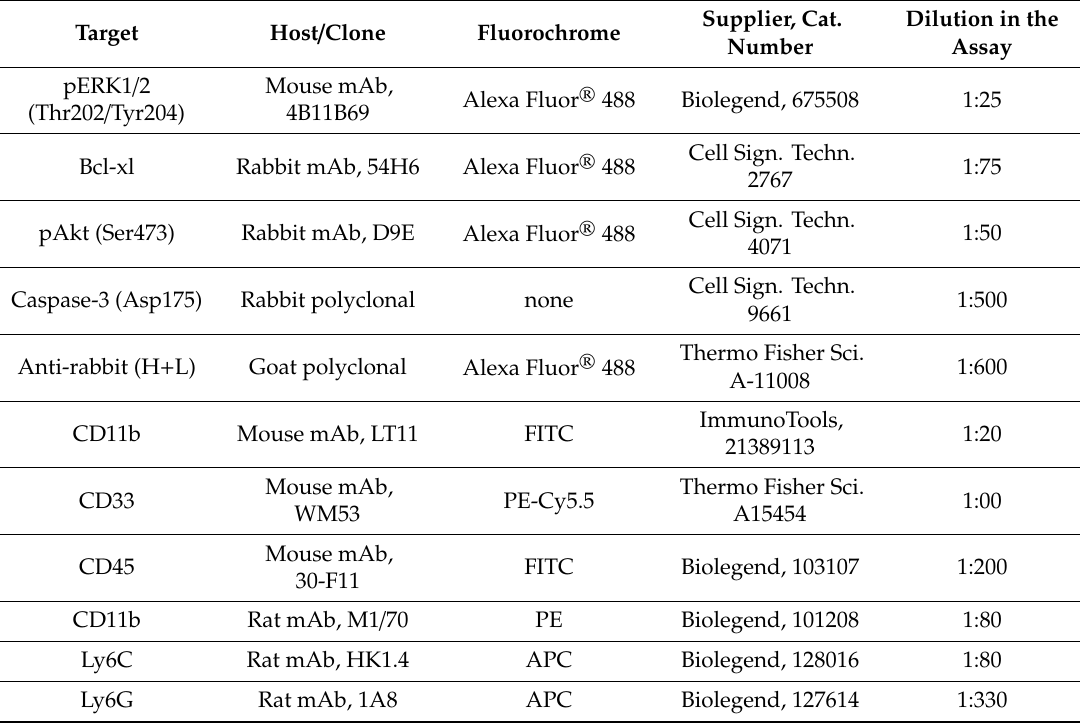
Table 2. List of the antibodies used for flow